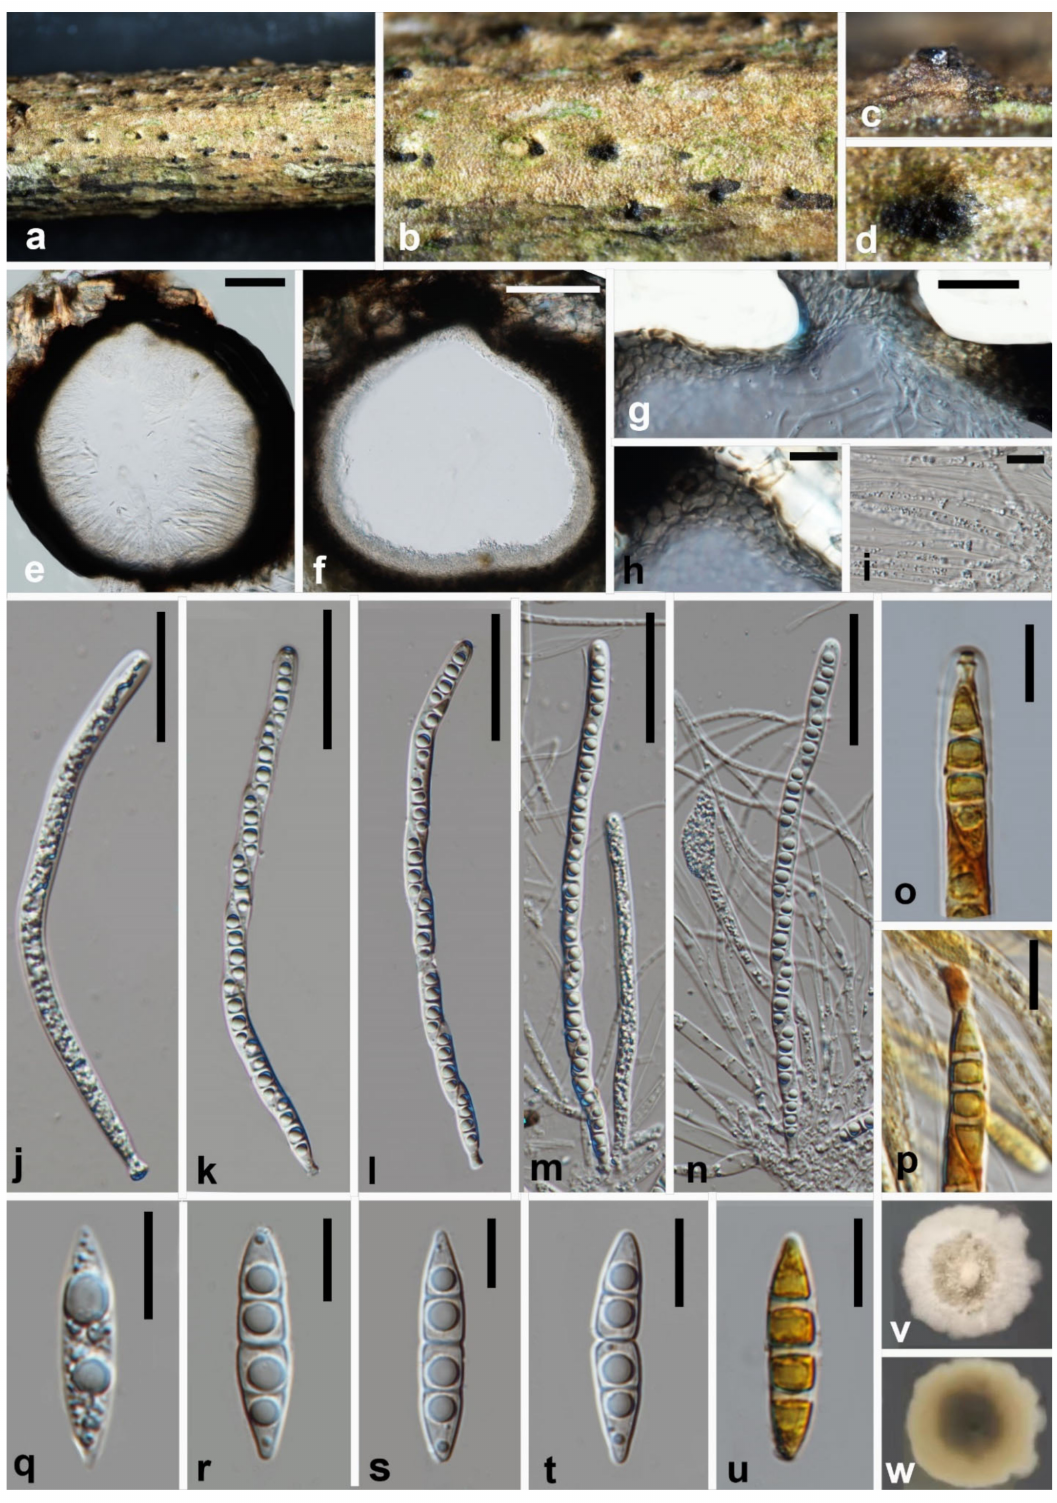
Figure 5. Melomastia winteri (HKAS 121314, holotype). ( a – d ) Ascomata on the substrate. ( e , f ) Vertical of the ascoma. ( g ) Vertical section of the ostiole. ( h ) Peridium. ( i ) Pseudoparaphy- ses. ( j – n ) Asci. ( o ) Ocular chamber in Lugol’s iodine. ( p ) Pedicel in Lugol’s iodine. ( q – u ) Ascospora (( u ) in Lugol’s iodine). ( v , w ) Upper and reverse view of the colony on PDA after 14d. Scale bars: ( e , f ) = 100 µ m, ( g , h , i , o – u ) = 10 µ m, ( j – n ) = 40 µ